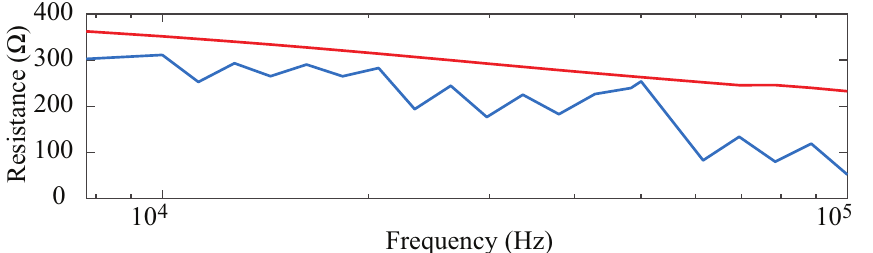
Figure 2. Sample of participant segmental leg resistance with (blue) and without (red) artifacts from visual data inspection prior to